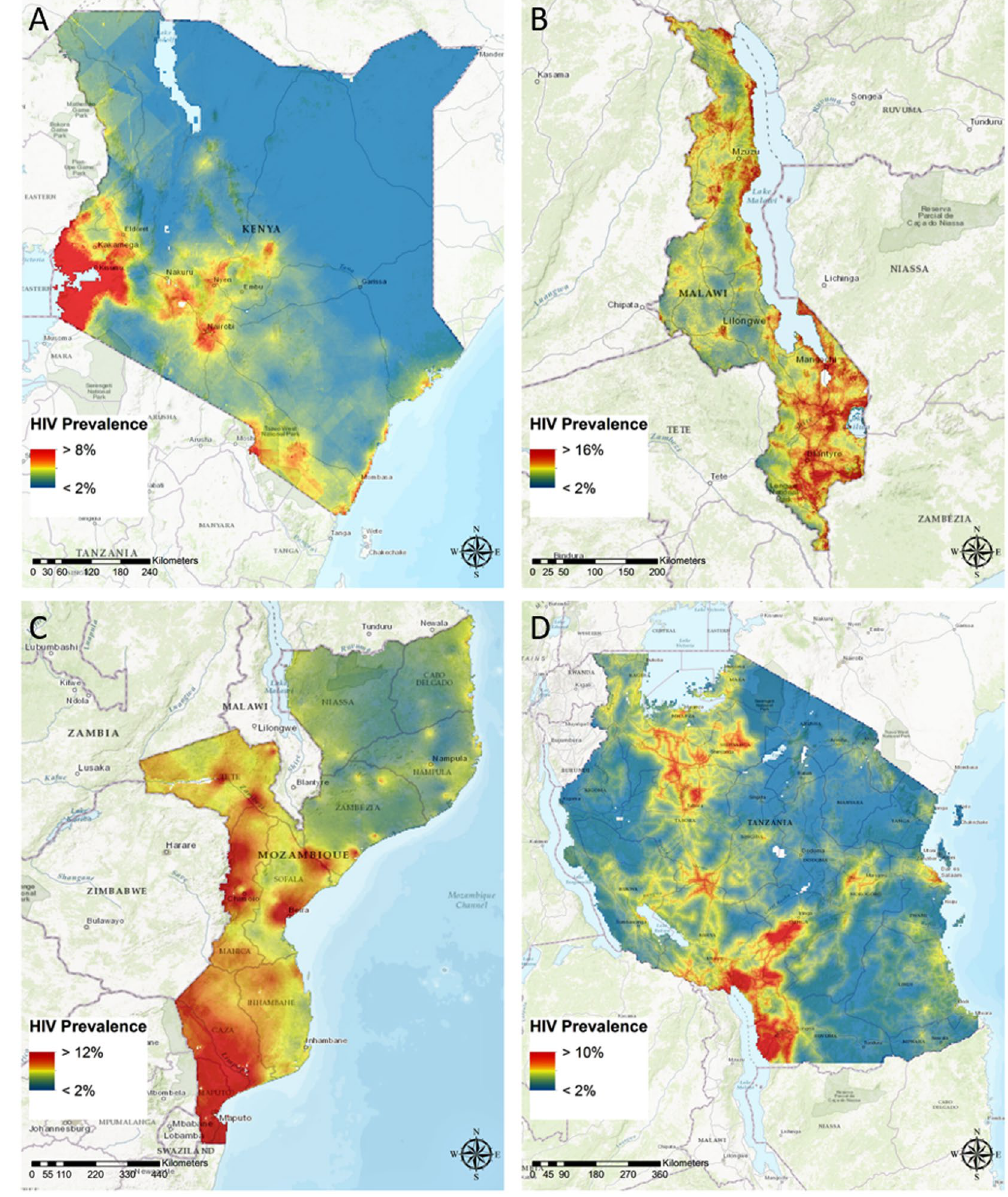
Figure 2. High resolution maps for HIV prevalence in ( A ) Kenya; ( B ) Malawi; ( C ) Mozambique; and ( D ) Tanzania. Maps were created using ArcGIS ® software by Esri version 10.3 42